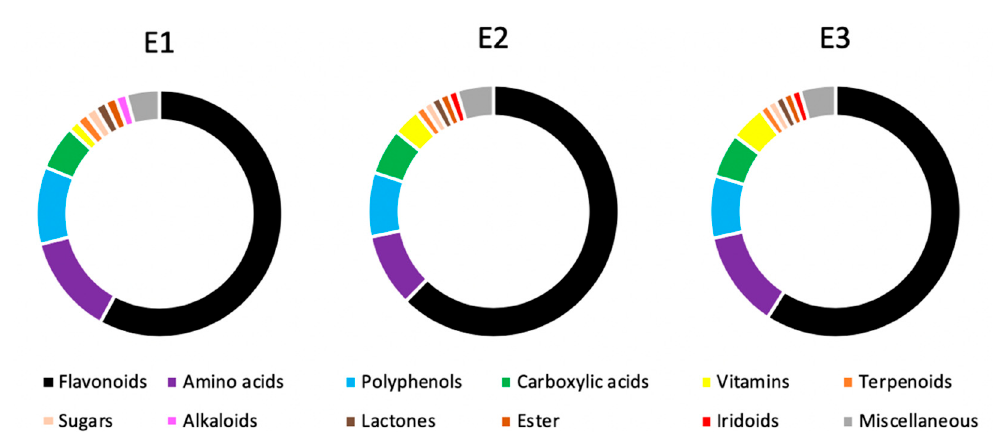
Table 1. Summary of the putative identification of phytonutrients in the extracts, with compounds pertaining to each extract (E1, E2, and E3) marked —if present and —if absent. Compounds are organized by chemical classification.